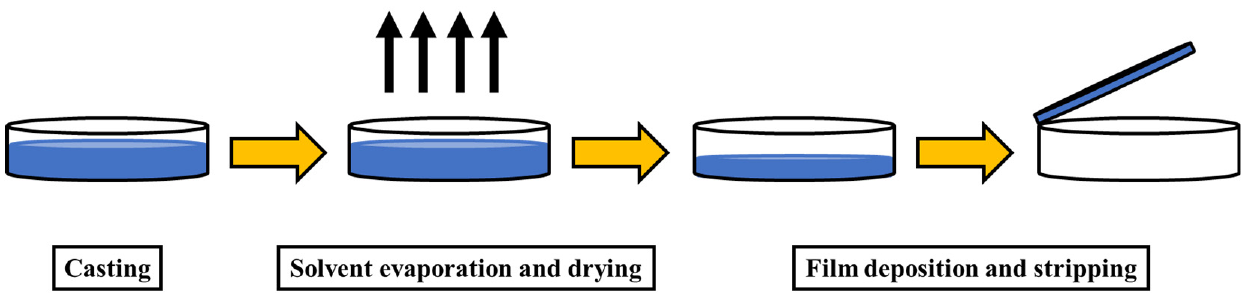
Figure 8. Cast-drying method for nanocomposite film formation.